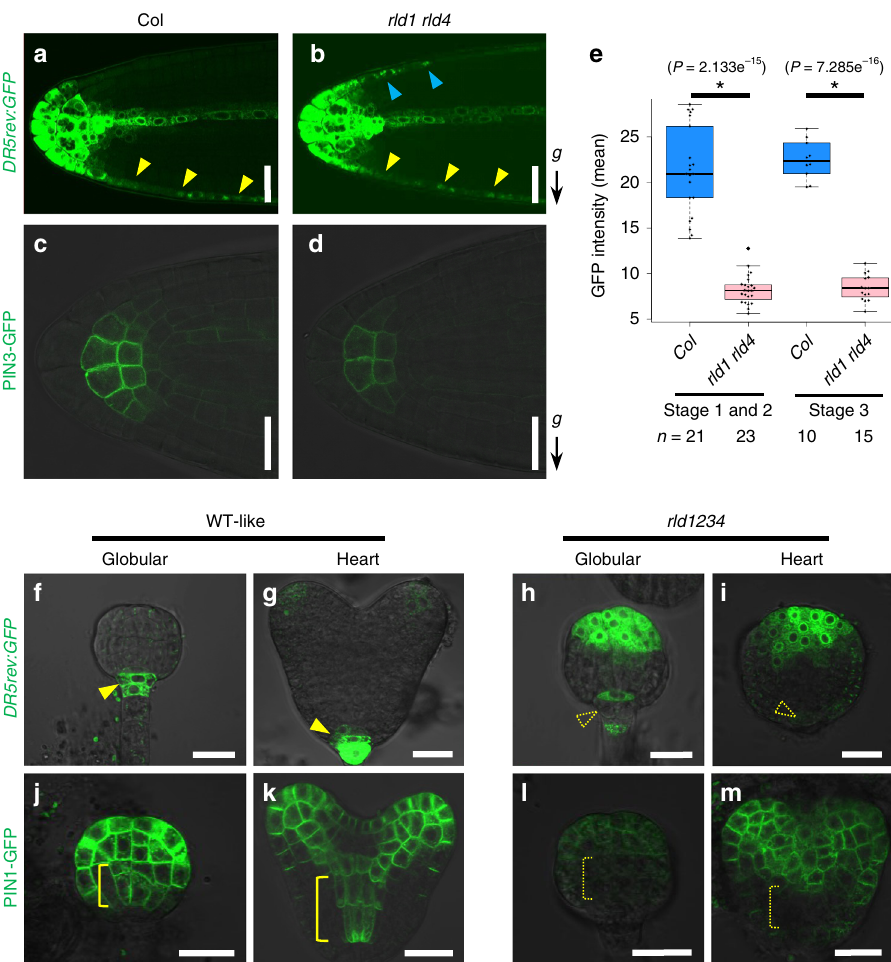
Fig. 2 RLD genes regulate auxin transport through the control of PIN localization. a – d DR5rev:GFP ( a , b ) and PIN3-GFP ( c , d ) expression in lateral root tips of Col ( a , c ) and rld1-2 rld4-1 ( b , d ). Arrowheads indicate DR5rev:GFP expression in lateral root cap cells (upper side, blue; lower side, yellow). e GFP intensity in the central columella cells of lateral roots of Col and rld1-2 rld4-1 harboring PIN3p:PIN3-GFP . Median and quartile values are provided by the central line and box boundaries. Whiskers show min to max values. n , sample number of three biologically independent experiments. Asterisks indicate signi fi cant differences by Student ’ s t test ( P < 0.05). Source data are provided as a Source Data fi le. f – m DR5rev:GFP ( f , g , h , i ) and PIN1-GFP ( j , k , l , m ) expression in WT-like ( f , g , j , k ) and rld1-2 rld2-2 rld3-2 rld4-1 ( h , i , l , m ) embryos dissected from ovules of plant homozygous for rld1-2 , rld3-2 , and rld4-1 and heterozygous for rld2-2 at the globular ( f , h , j , l ) and heart stage ( g , i , k , m ). Arrowheads and brackets indicate strong GFP signals in the hypophysis/ radicle tip and provasculature of basal region, respectively, while blank arrowheads and dashed brackets represent disappeared GFP signals in respective regions. Arrow marked with “ g ” represents the direction of gravity. Scale bars, 20 μ m ( a – d , f – m